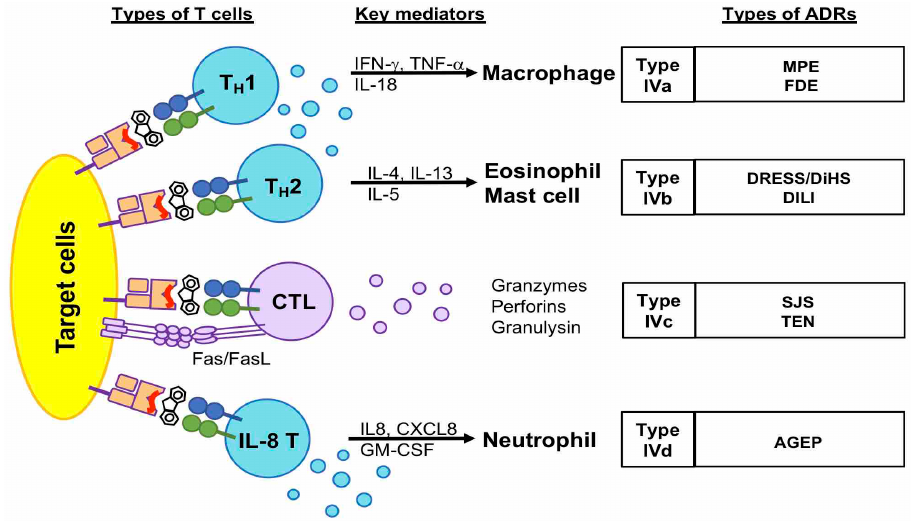
Figure 1. The characteristics of type IV (delayed-type) drug hypersensitivity. Delayed-type drug hypersensitivity is mostly induced by T cells. They are subdivided into four types (IVa, IVb, IVd, and IVc) according to the types of T cells, such as T H 1, T H 2, IL8 T H cells, and cytotoxic T cells. The types IVa, IVb, and IVd are mediated by T H cells and the activation of downstream granulocytes, such as macrophages, mast cells, eosinophils, and neutrophils. By comparison, type IVc is mainly mediated by cytotoxic T cells, which induce target cell death by releasing cytokines, such as granulysin, granzyme B, and perforin, or direct interaction of Fas/FasL. Abbreviations: FDE, fixed drug eruption; MPE, maculopapular eruption; AGEP, acute generalized exanthem pustulosis; DRESS, drug reactions with eosinophilia and systemic symptoms; DiHS, drug-induced hypersensitivity syndrome; DILI, drug-induced liver injury; SJS, Stevens–Johnson syndrome; TEN, toxic epidermal necrolysis.